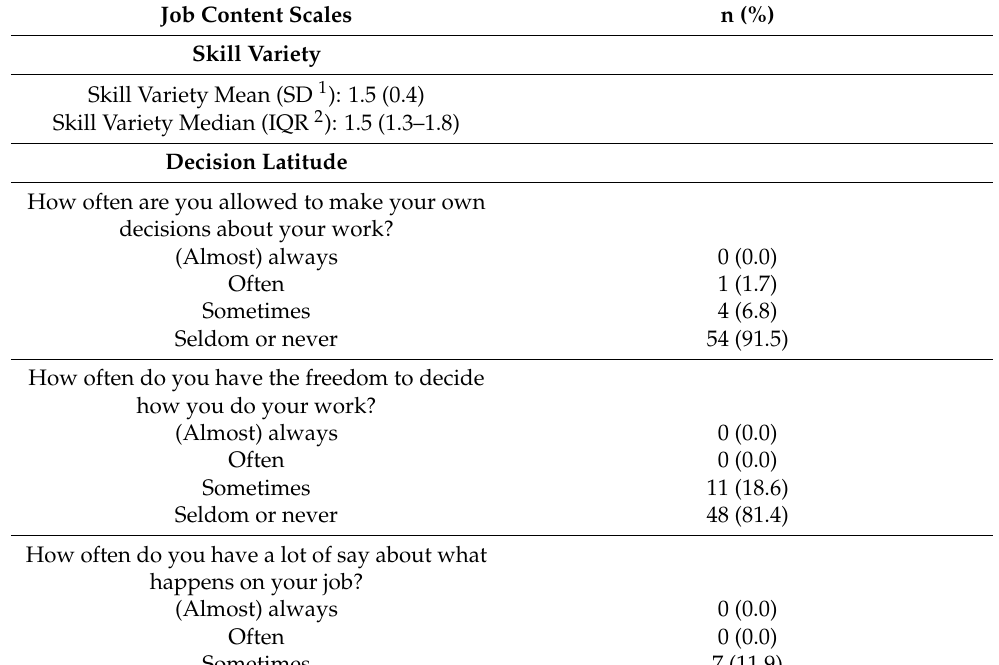
Table 5. Cont. Job Content Scales n (%) Skill Variety Skill Variety Mean (SD 1 ): 1.5 (0.4) Skill Variety Median (IQR 2 ): 1.5 (1.3–1.8) Decision